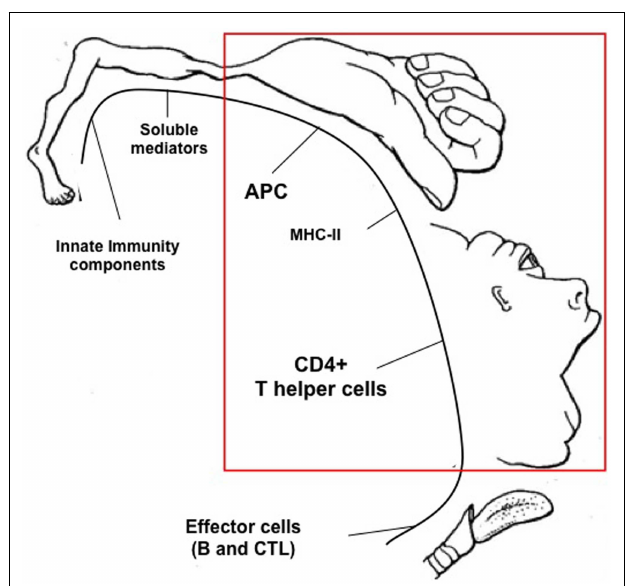
FIGURE 2 | Proposed hierarchic position of components of the immune system involved in the productive response against cancer . By similarity with the pictorial representation of the “Cortical Homunculus” of W. Penfield, a hypothetical “Immunological Homunculus” is depicted identifying specific components of the immune system as the hierarchically most important actors against the tumor.These are, in primis , the tumor antigen presenting function exerted, for example, by dendritic cells or by tumor cells expressing MHC class II molecules, and the MHC class II-restricted CD4 + T helper cells. Other important components are defined as effector cells, innate immunity components, and soluble